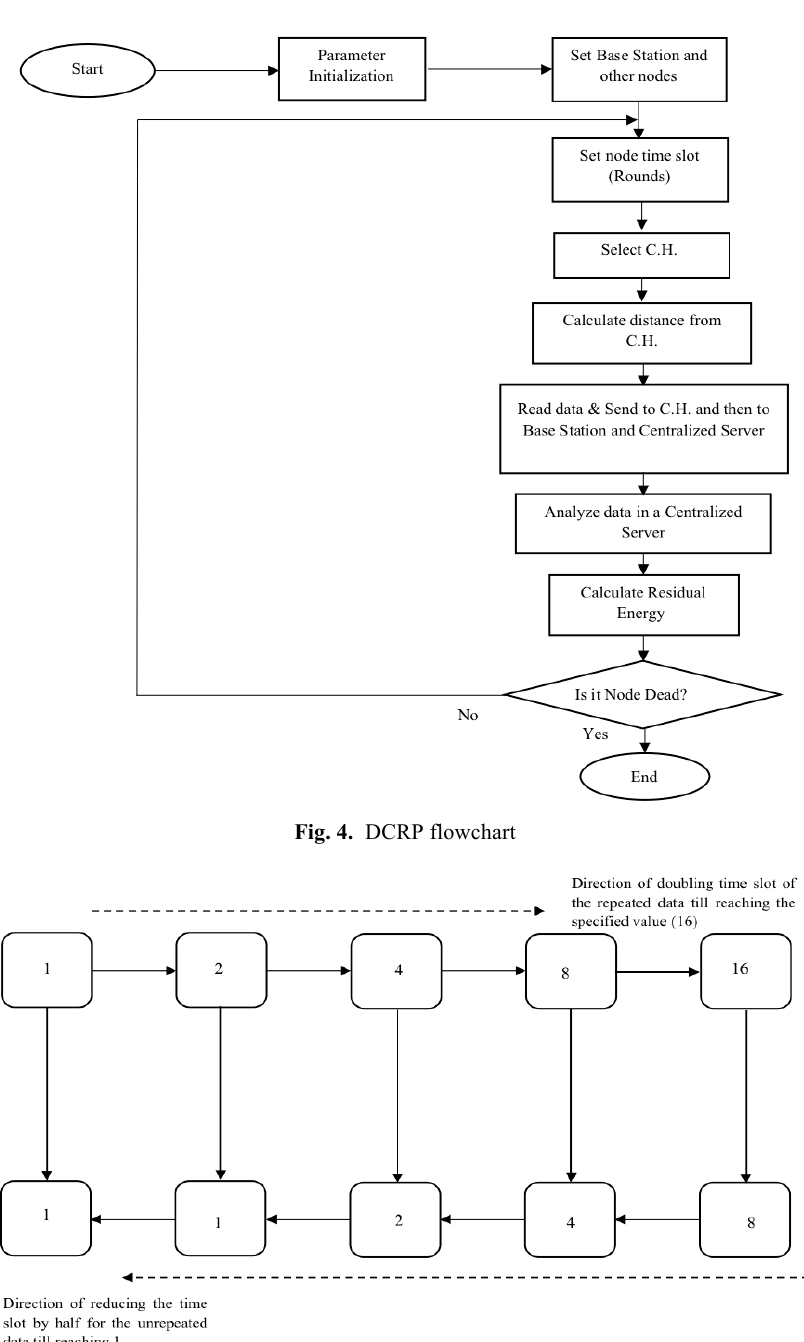
Fig. 5. Node time